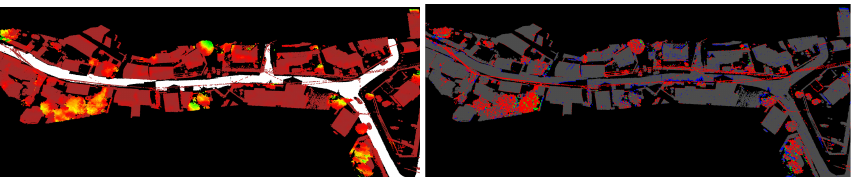
Figure 9. ( Left ) Echo scatter in the most detailed scale, KNN = 25, ( Right ) quantized echo value for each point. Intensity of response indicates the normalized value of response intensity between the various laser